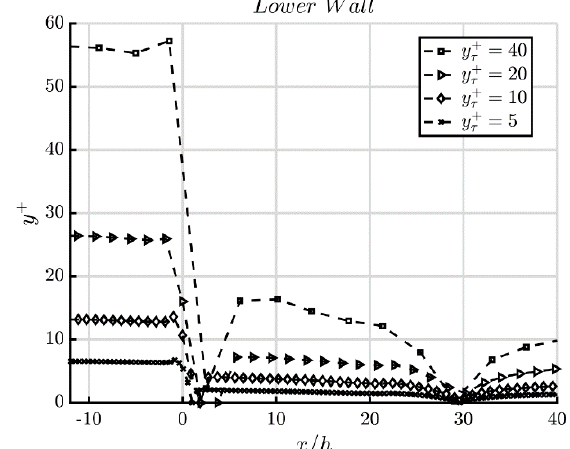
Figure 9. Lower wall variations for each grid resolution.